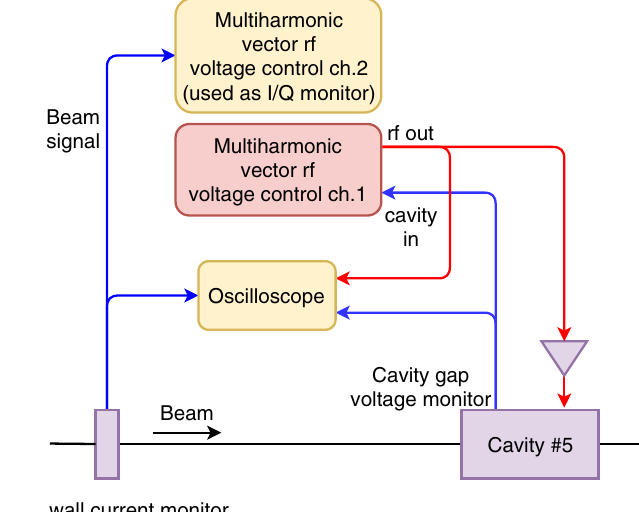
FIG. 26. Comparison of the calculated and measured gap voltage waveforms of (top) a sawtooth wave and (bottom) a square wave. FIG. 27. Beam test